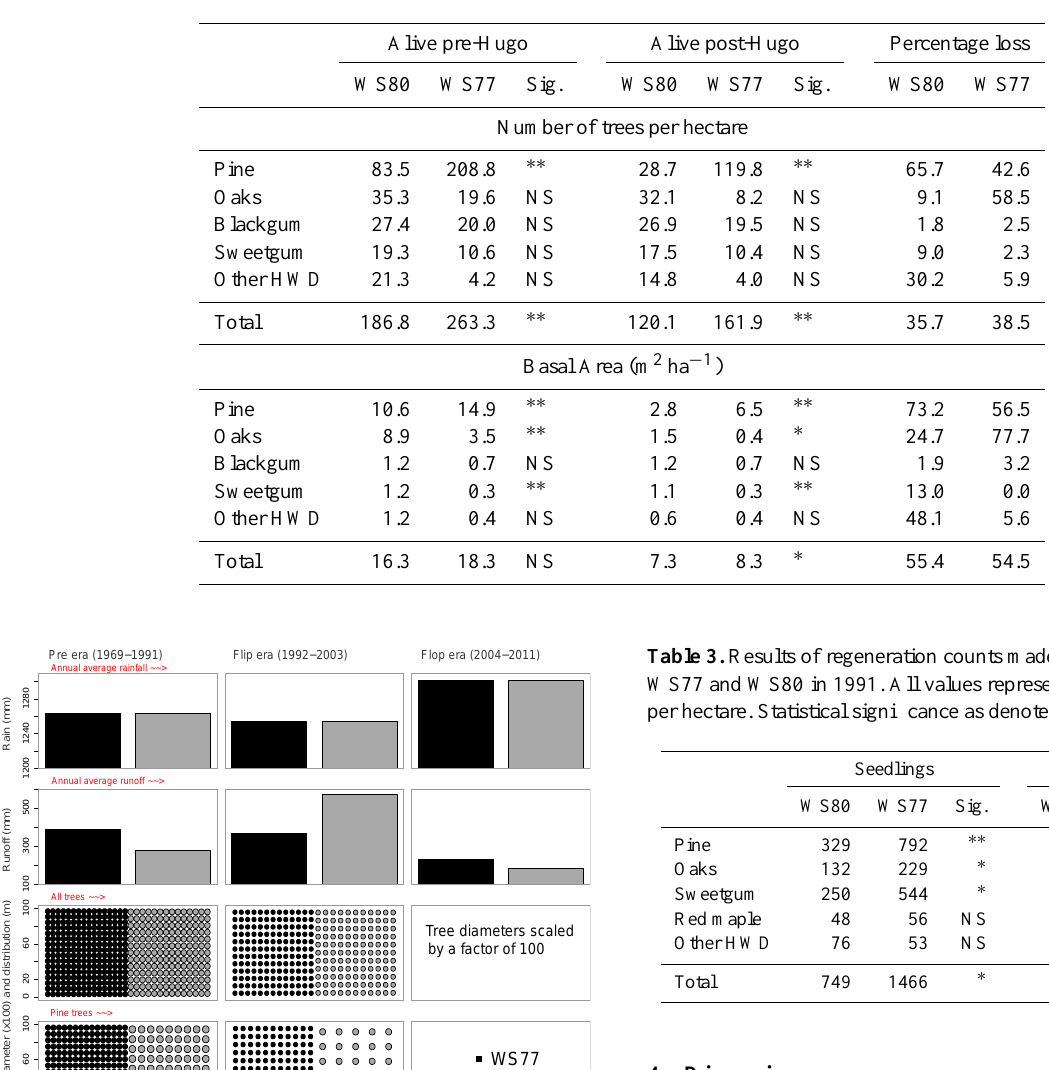
Table 2. Results from tree inventory data from 1991 that recorded mortality and living trees. Trees alive pre-Hugo were estimated by summing the following: alive post-Hugo+recorded mortality+salvage. Counts of trees salvaged from WS77 post-Hugo were inferred by aerial photo interpretation. Significance of t tests of differences in mean number of trees and mean basal area between WS77 and WS80 are shown. Standardized t test: mean WS80 6= WS 77; ∗∗ significant at α = 0 . 01; ∗ significant at α = 0 . 05; NS not significant α = 0 . 05; HWD hardwood species.